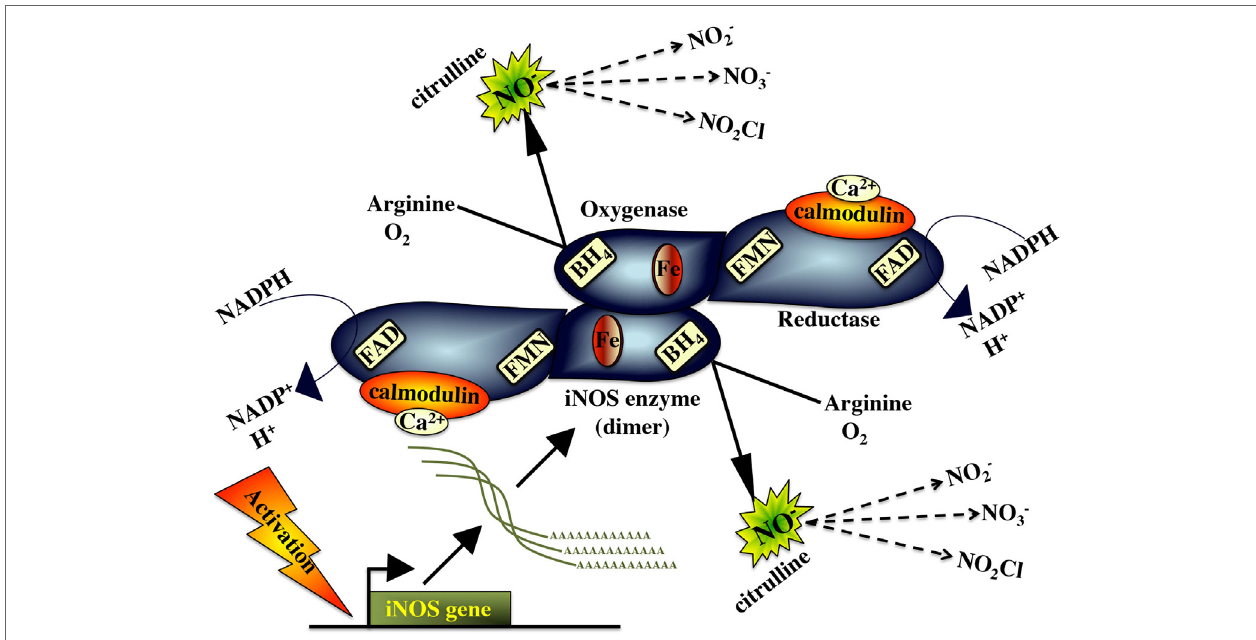
FigURe 4 | Inducible nitric oxide synthase and the nitric oxide